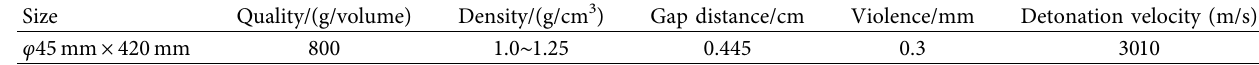
Table 4: Parameters of No. 2 rock emulsion explosive.